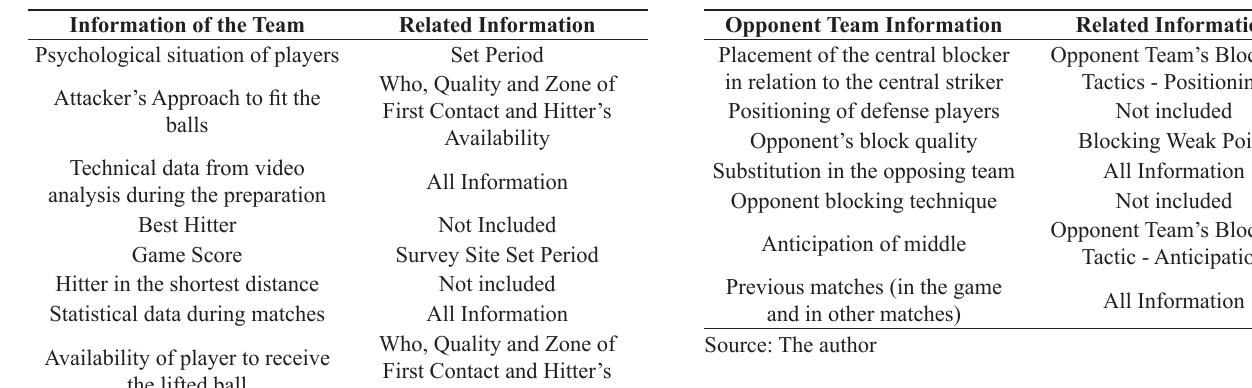
Table 3: List of information related to the setter’s own team com- plemented by the coaches with the information contemplated in the questionnaire during the Attack Processes.